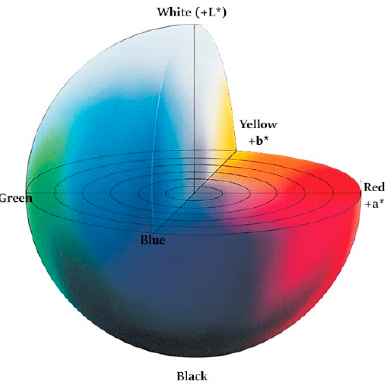
Figure 11. Schematic of the colour spectrum L, a, b of the CIELab system [31] (Photo courtesy of Konica Minolta, Inc. All rights reserved).